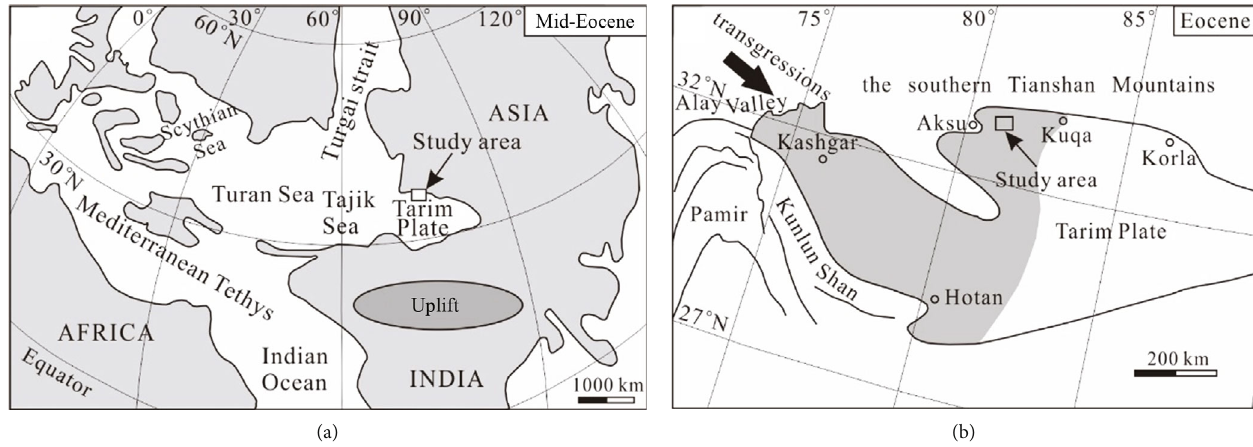
Figure 1: (a) Paleogeographic sketch map of the mid-Eocene in the Tethyan realm (modi fi ed from [31, 32]); (b) Eocene paleogeographic map of the Tarim Plate (modi fi ed from